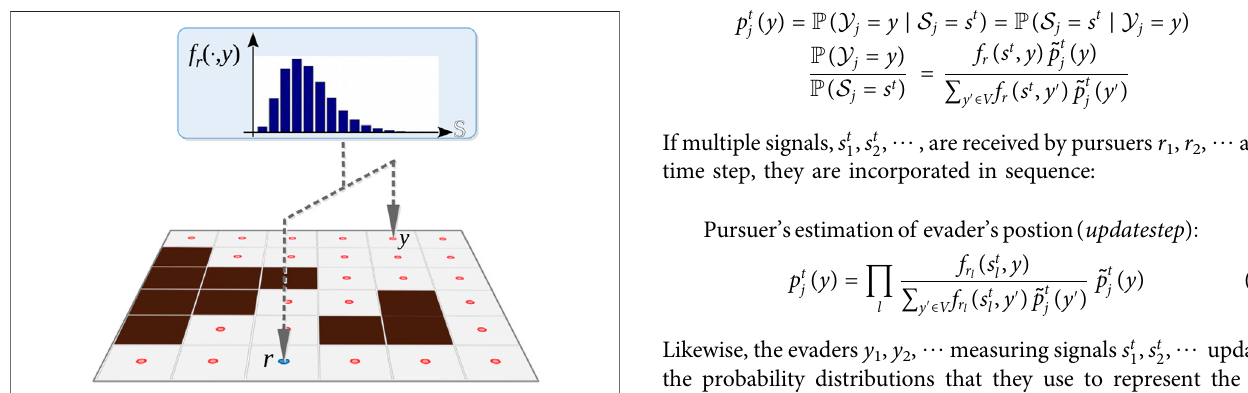
Frontiers in Robotics and AI |